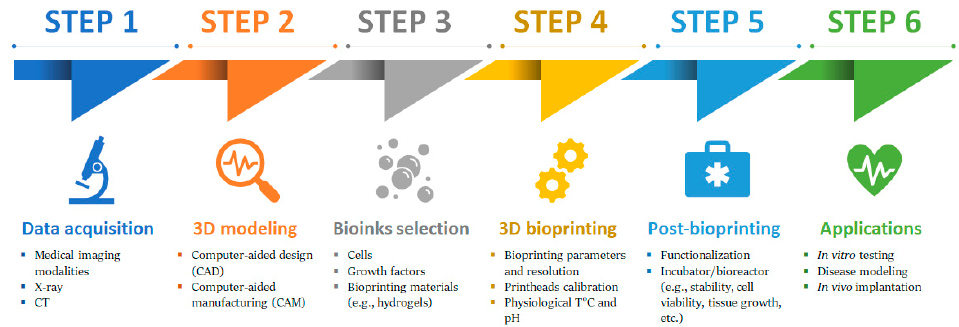
Figure 1. Typical manufacturing workflow for 3D bioprinting process and bioprinted